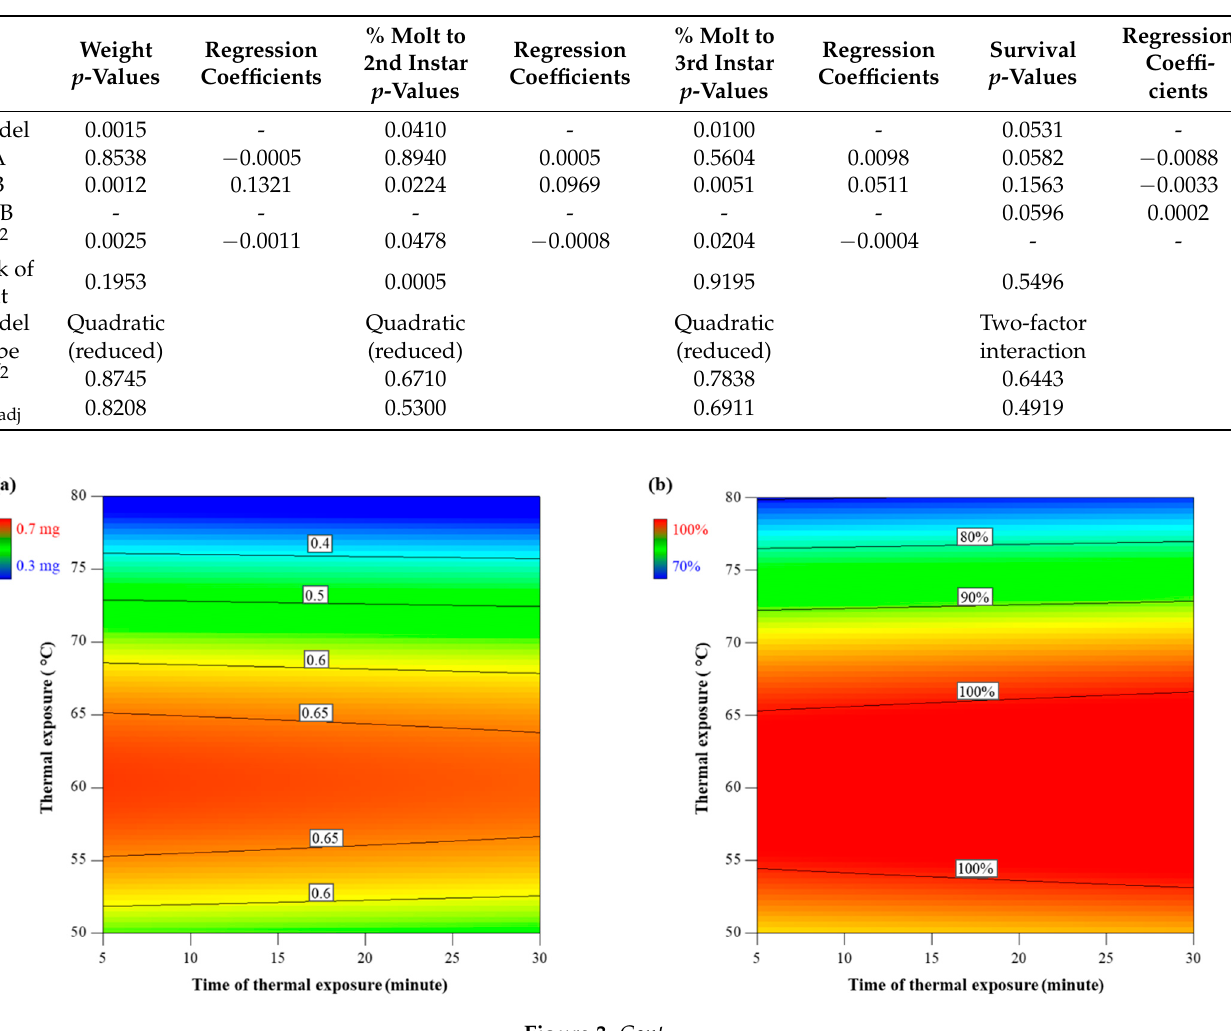
Table 2. p -values, regression coefficients, and response surface-model fitting diagnostic statistics for western corn rootworm responses to a 2-factorial experiment at mild thermal exposure (50–80 ◦ C) and extended time of thermal exposure (5–30 min).